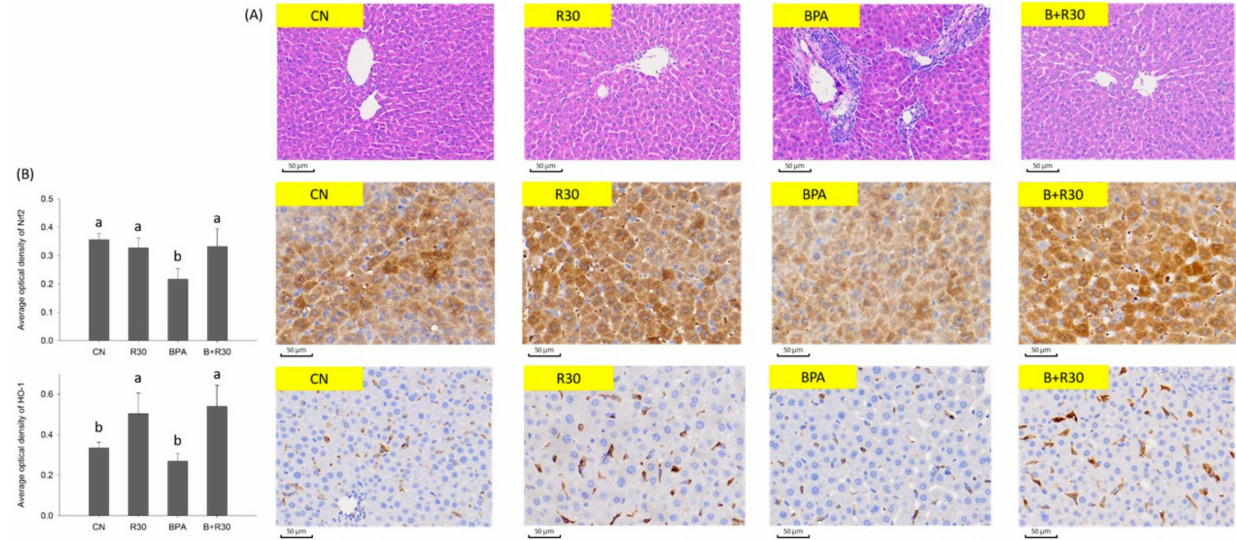
Figure 2. ( A ) Representative pictures of the liver sections stained with hematoxylin and eosin (H&E) examined under a microscope. ( B ) Expression of Nrf2 and HO-1 observed in liver immunohistochemistry of male offspring rats. n = 4–8 per group; a–b p < 0.05, significantly different from other groups. CN = control group; R30 = group administered 30 mg/kg/day of RBE; BPA = group administered bisphenol A at 50 µ g/kg/day; BPA + R30 = group administered 30 mg/kg/day of RBE and bisphenol